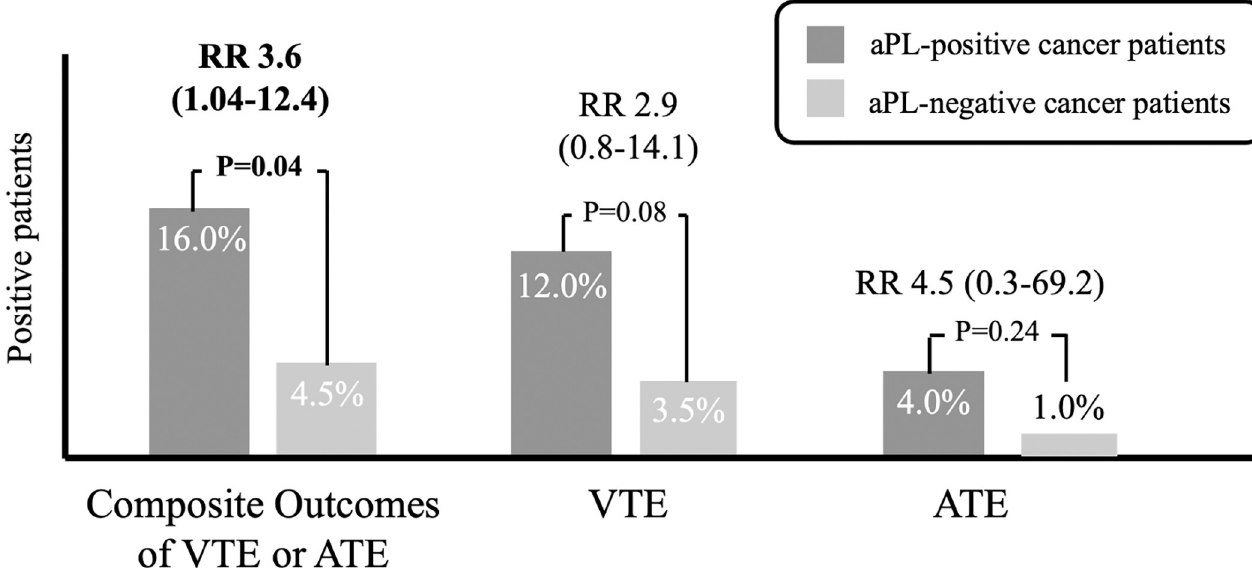
Fig 3. Composite outcomes of VTE or ATE, VTE and ATE in aPL-positive and aPL-negative cancer patients. Abbreviations: ATE = arterial thrombotic events, VTE = venous thromboembolic events, RR = relative